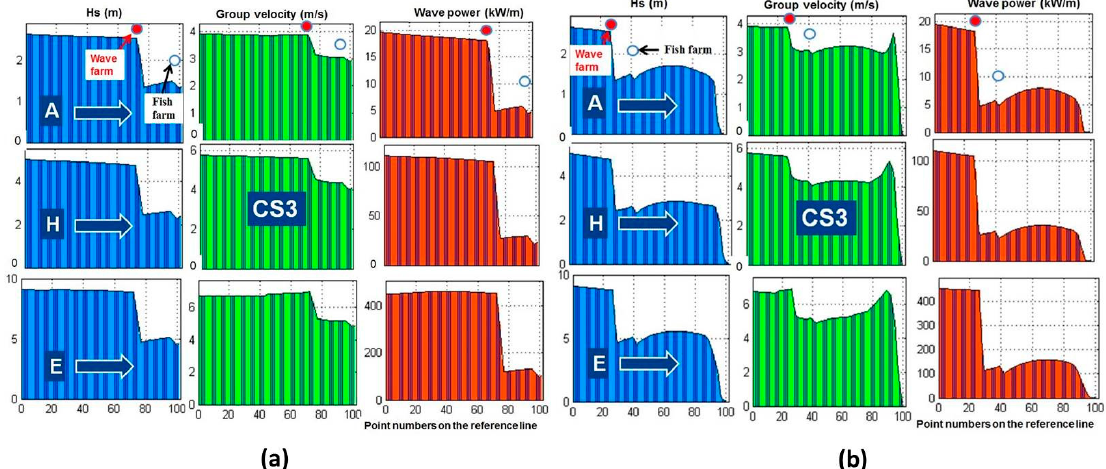
Figure 9. CS3 (optimistic scenario for the wave farm), results of the SWAN model simulations along the reference lines (RL1 and RL2). The wave parameters represented are: significant wave height, group velocity, and wave power. The reference lines are divided into 100 points equally spaced. ( a ) Model results along RL1; ( b ) model results along RL2. A—average wave conditions, H—high wave conditions, E—extreme wave conditions. The locations of the wave and fish farms are indicated in the upper figures with red and white circles, respectively.